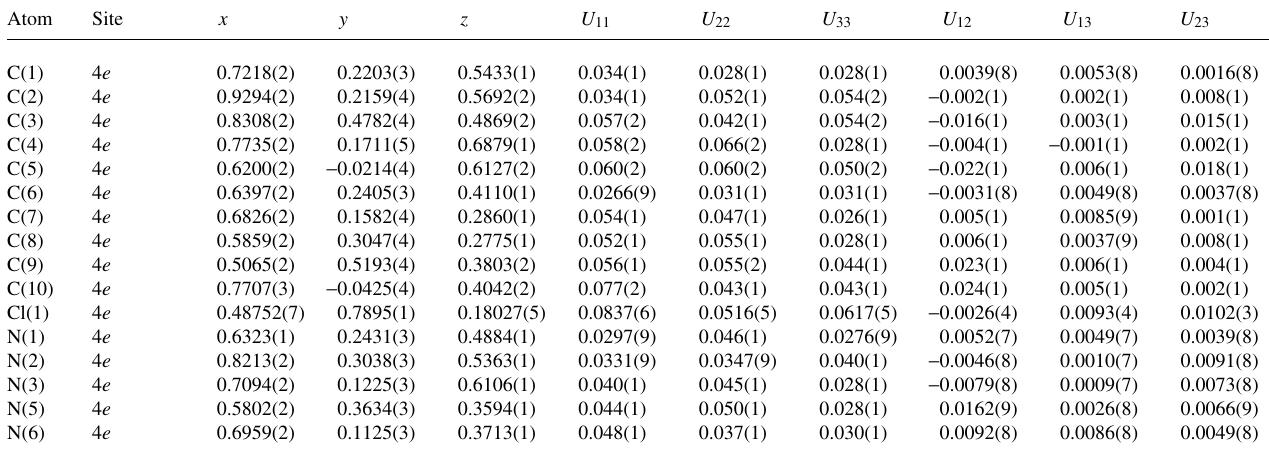
Table 3. Atomic coordinates and displacement parameters (in Å 2 )